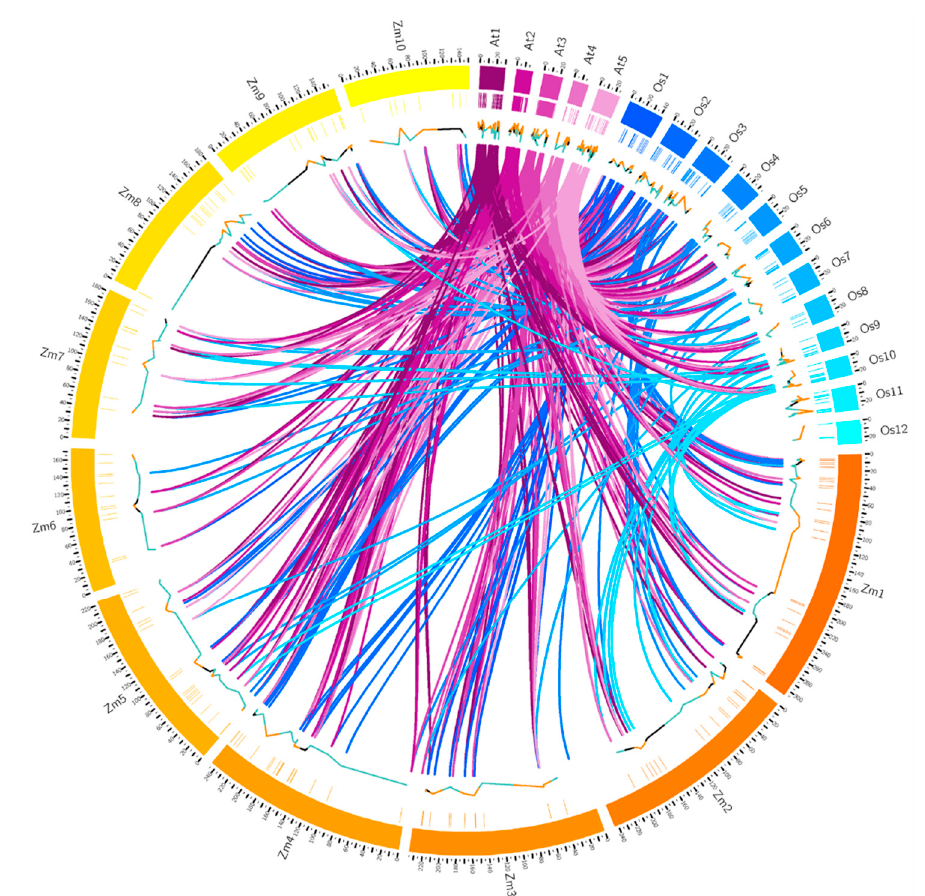
Figure 2. Circos map of RLCK genes in maize, rice and Arabidopsis. The outer two circles were proportional chromosomes for maize, rice, and Arabidopsis in megabase (Mb) units. The third circle represented each RLCK gene distribution on chromosomes. Lines below each chromosome represent the intron numbers of RLCK genes (orange > 5 introns, black = 5 introns, blue < 5 introns). Innermost colored lines represent synteny gene pairs among the genomes of maize, rice, and Arabidopsis.